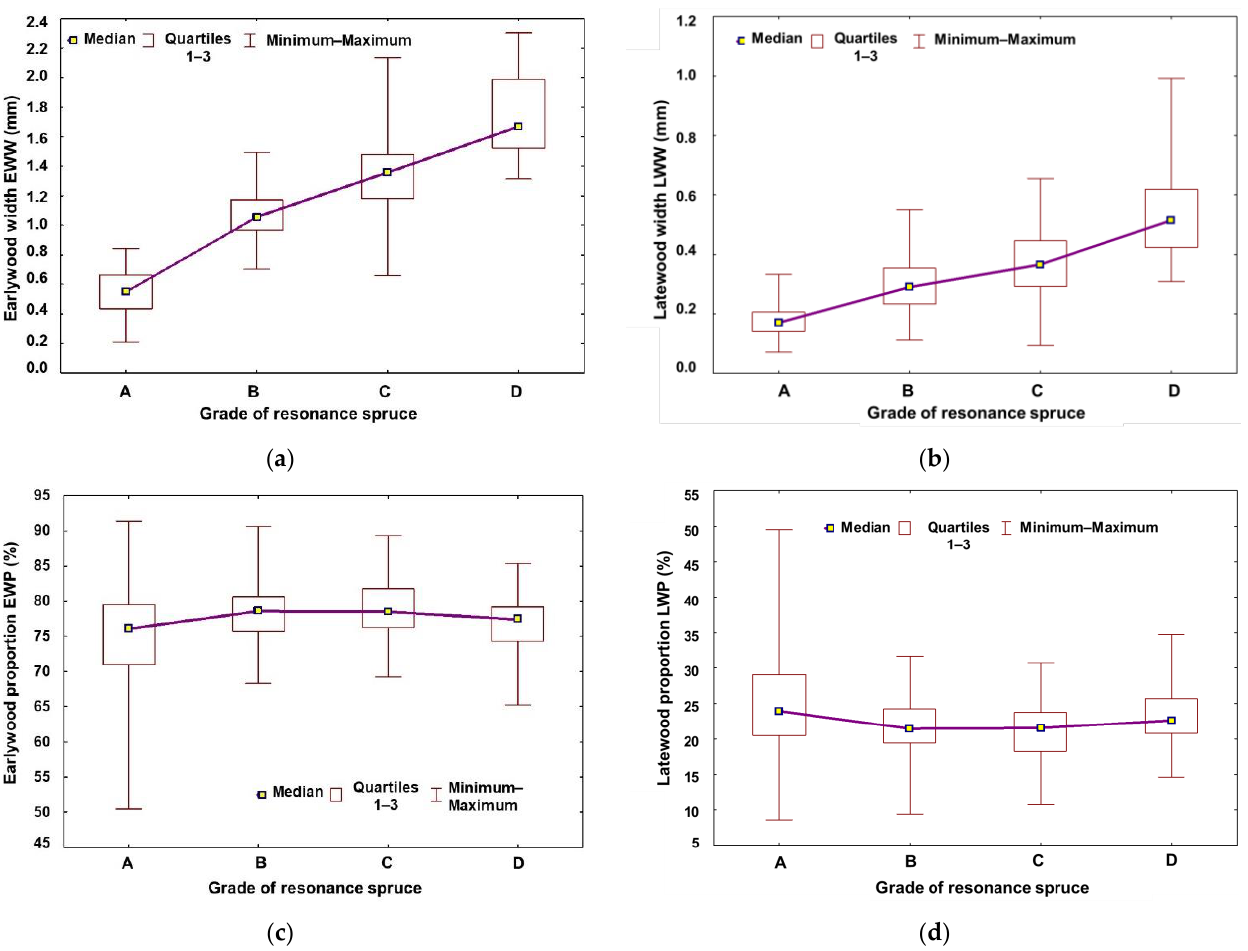
Figure 4. Variation in the anatomical parameters according to the wood grade: ( a ) the early wood width EWT; ( b ) the late wood width LWT; ( c ) the early wood proportion EWP; ( d ) the late wood proportion LWP.